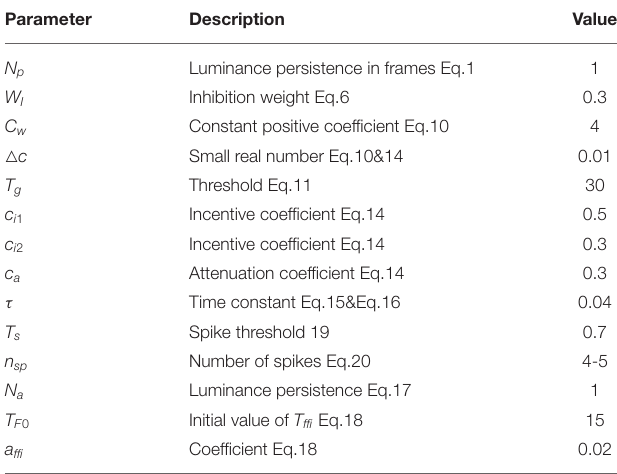
FIGURE 4 | A Winner-take-all network for looming spatial localization. The solid arrow lines and dashed lines represent excitation and inhibition, respectively. The hidden layer contains 16 neurons h 1 ∼ h 16 . The red neuron MLG 1 3 represents the first activated neuron, the blue neuron MLG 1 4 is the second one. MLG 1 3 firstly activates h 3 and inhibits the rest of hidden neurons. Thus, the output of LSL layer is LSL 3 .